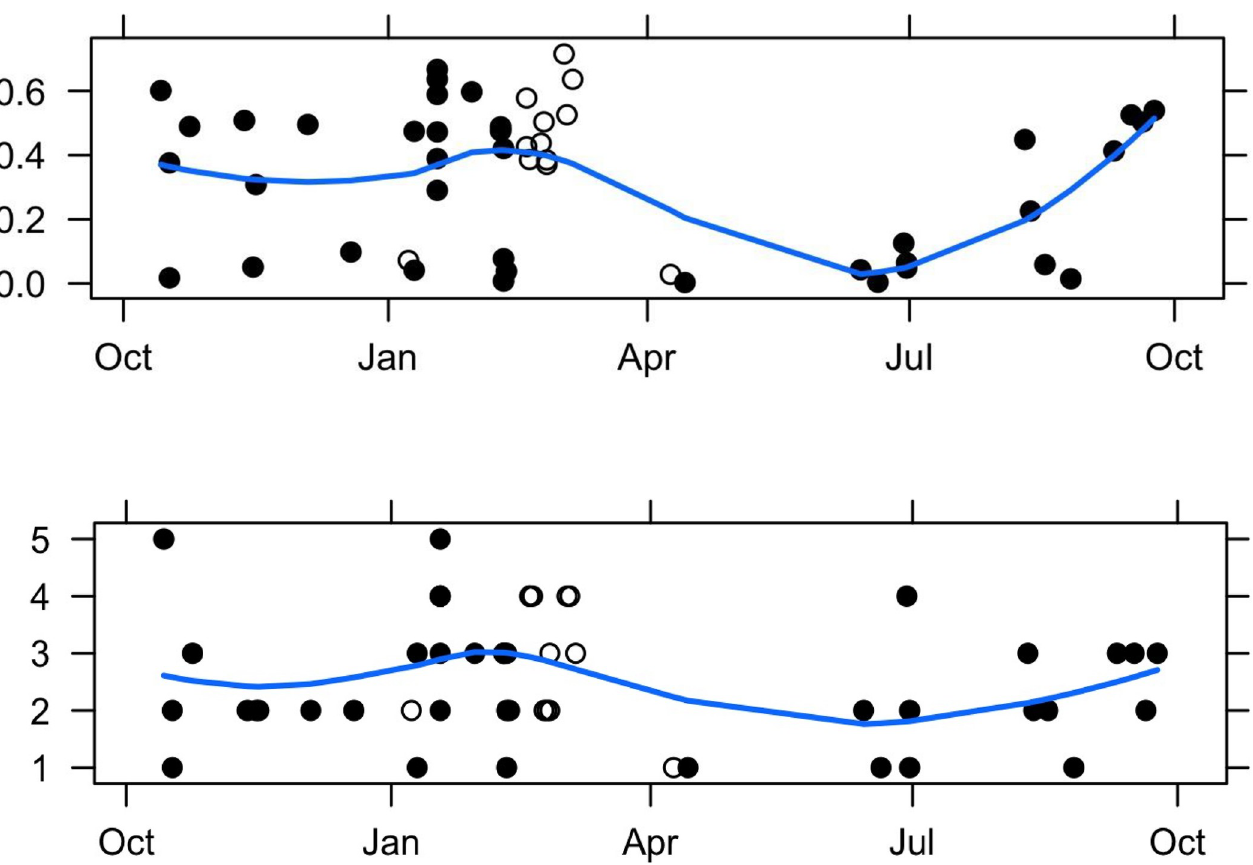
Fig 3. Seasonal trends in the diversity (top) and number (bottom) of Southern Resident killer whale prey species ( > 1%) per fecal sample. Open and filled symbols indicate samples from the outer coast and Salish Sea, respectively. The line indicates the predicted values from local polynomial regression. Data from May—September are from Ford et al.